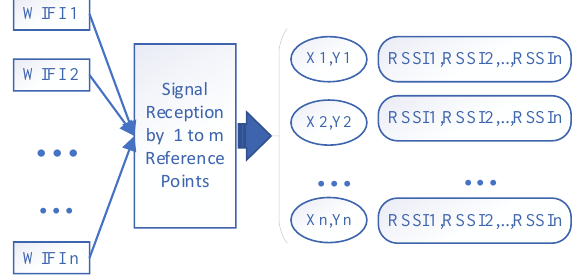
Figure 1 . The offline phase includes signal reception by reference points from different transmitters and forming a database